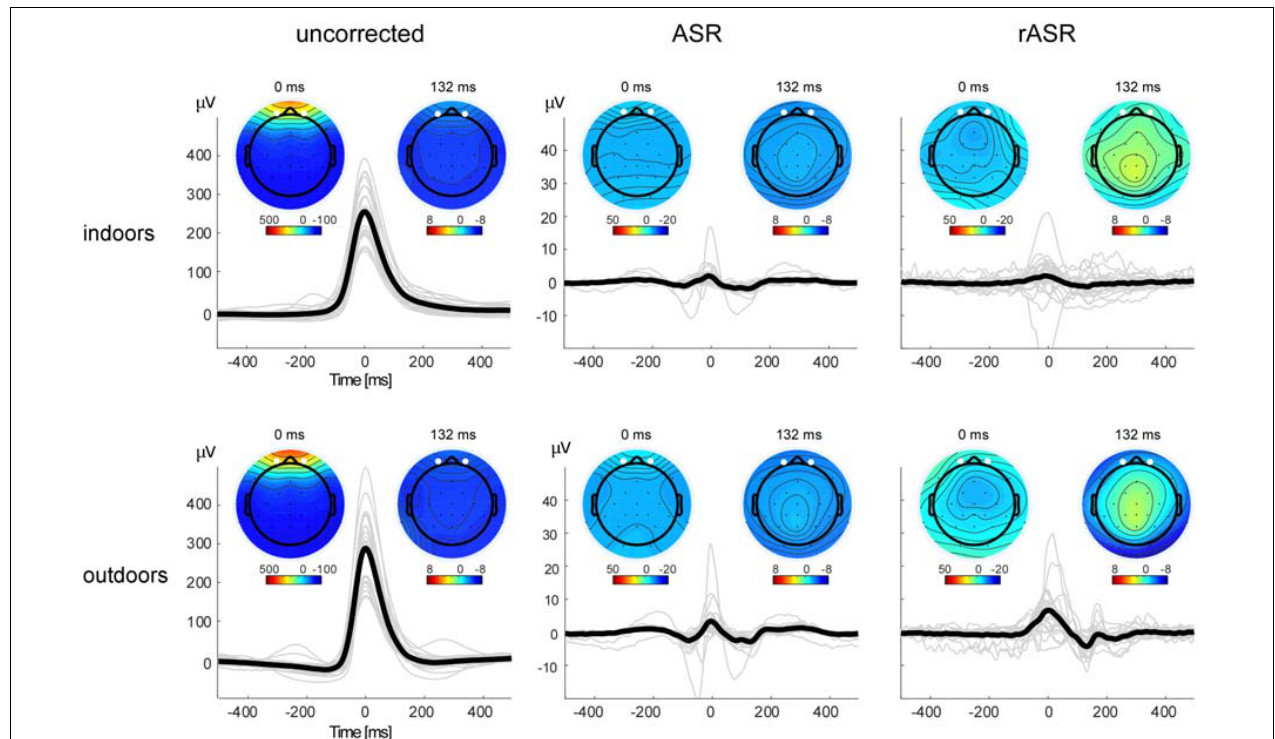
FIGURE 3 | Blink artifact topographies and time courses for all methods and conditions. Note the different y -axis scale for uncorrected and corrected data. The bold black lines show the grand average blink signal, the thin gray lines show single subject averages. Eye-blink potentials were measured as the mean between channels Fp1 and Fp2, marked as white points in the voltage maps. Blink potentials and blink voltage maps illustrate eye-blink morphologies and topographies before (left) and after (center, right) artifact correction. Smaller maps show the voltage distribution 132 ms post eye-blink maximum. In uncorrected data, the map reflects residual eye-blink activity, in corrected datasets, it is compatible with the interpretation of eye-blink generated event-related brain potentials.